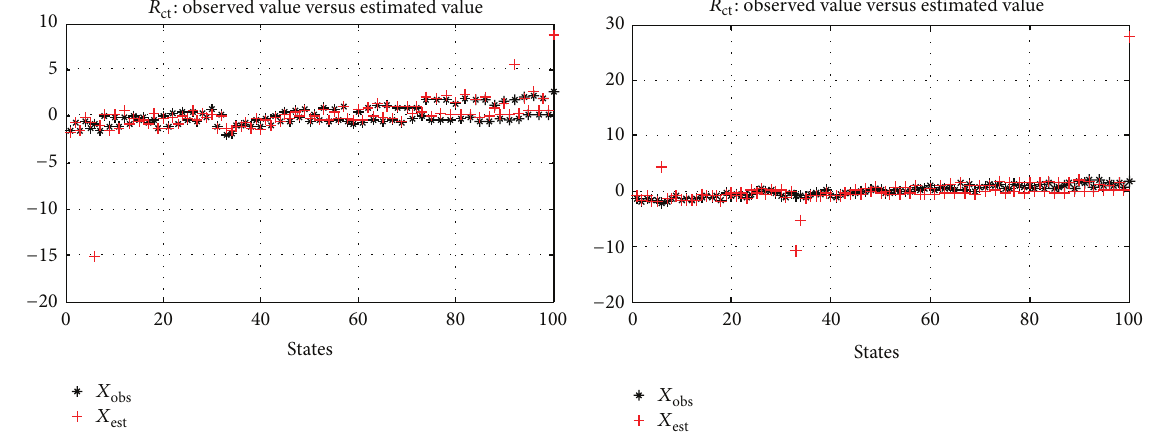
Figure 13: Comparison of the observed value and estimated value of 𝑅 𝑒 and 𝑅